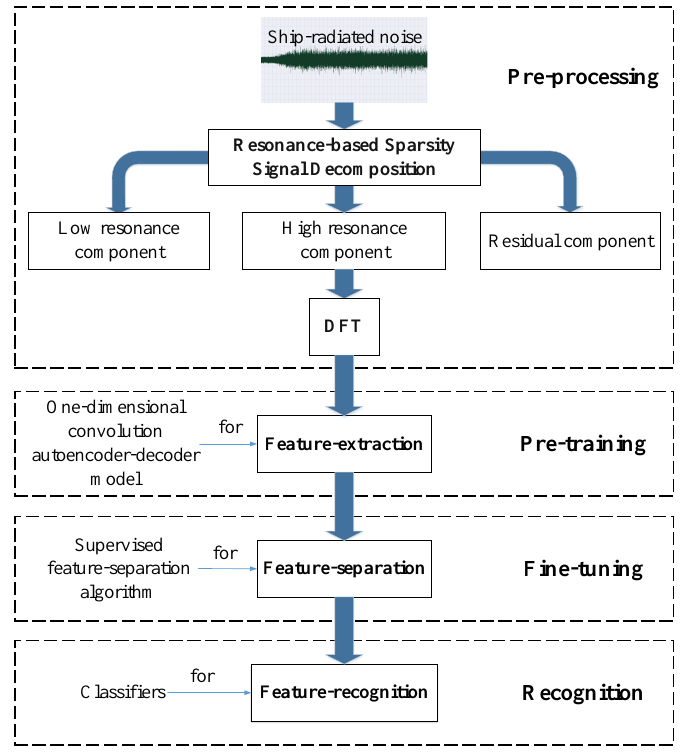
Figure 1. The whole process of underwater acoustic target